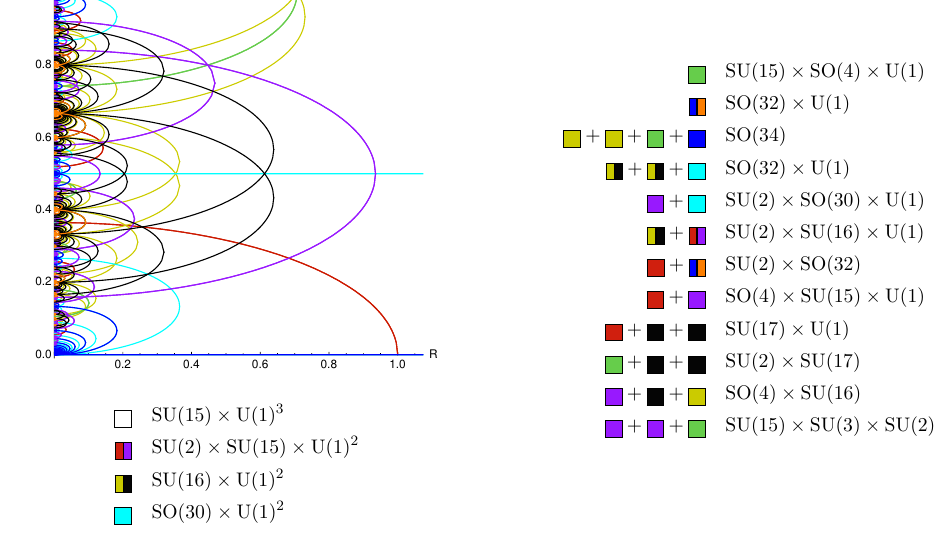
Figure 22. SO(32) heterotic with Wilson line A I = (( A ) 15 ; 0).